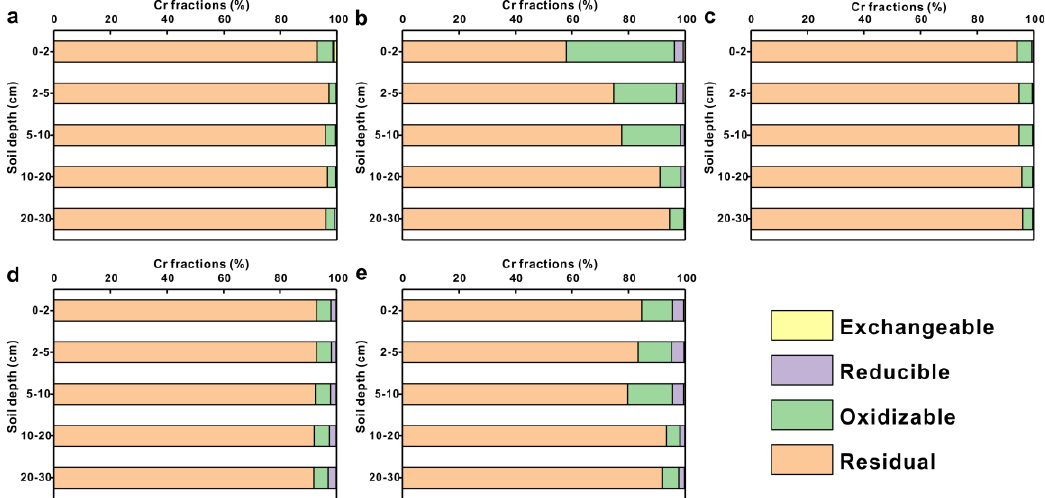
Figure 7. Percentage of exchangeable, reducible, oxidizable, and residual fractions of total Cr in soil profiles under different preservative – treated planks: ( a ) Background profile; ( b ) CCA-5; ( c ) ACQ-3; ( d ) CA-6; ( e ) CCA plus CA-3.